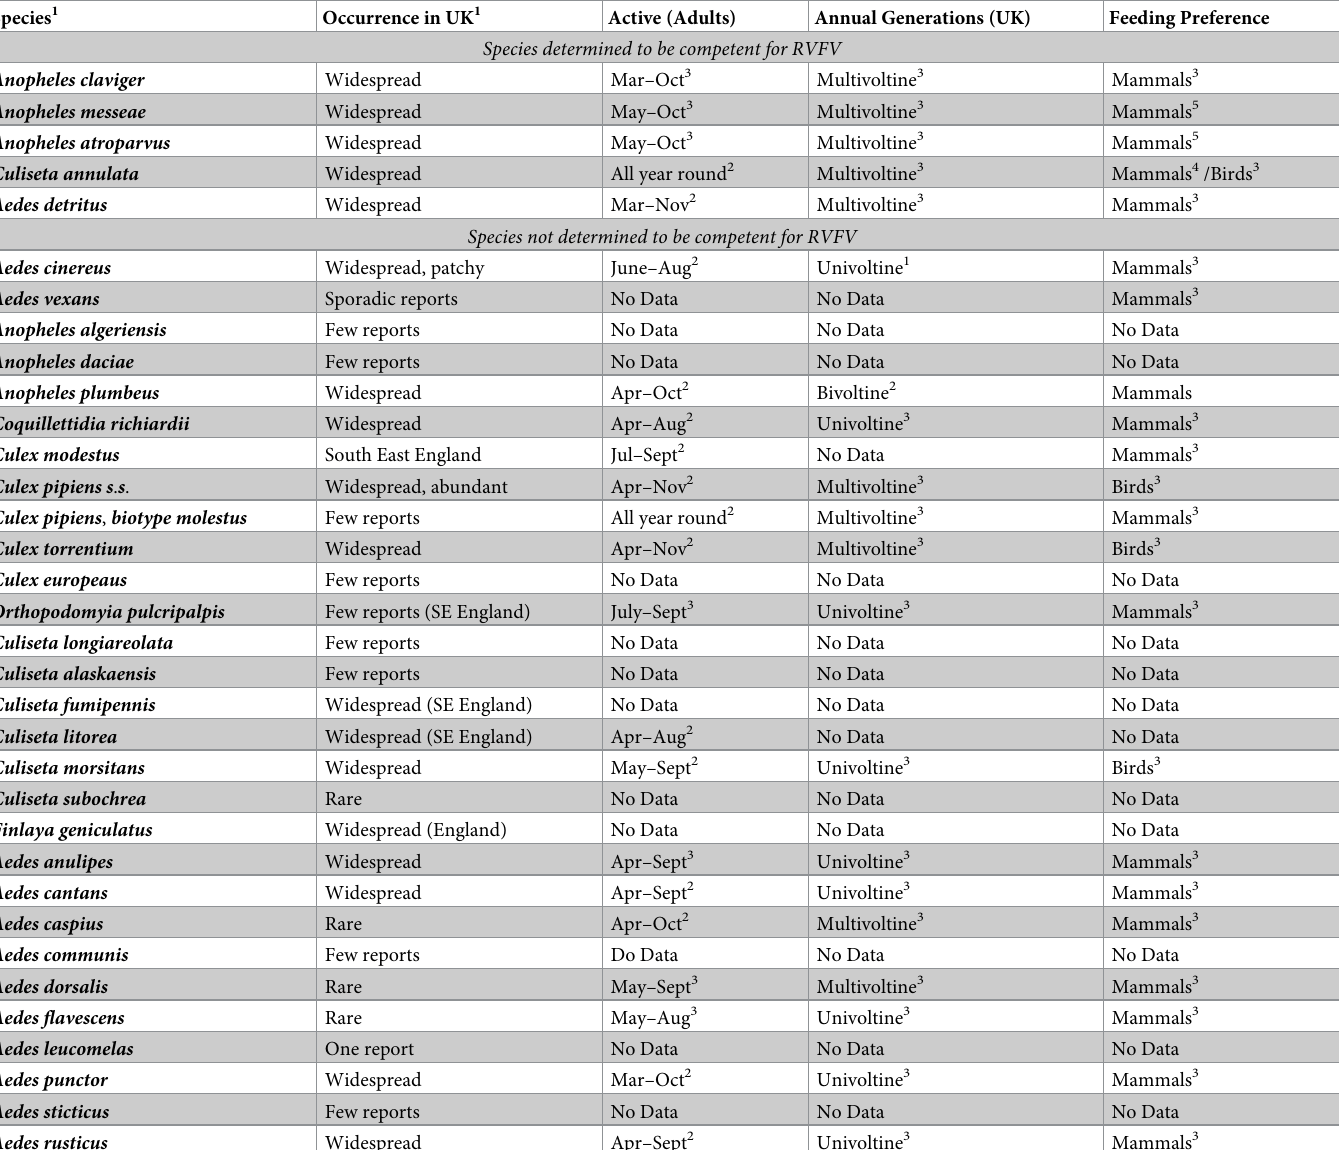
Table 1. Table of UK mosquito species bionomics. References are indicated with numerical superscripts: 1 = [34], 2 = [35], 3 = [36], 4 = [37], 5 =